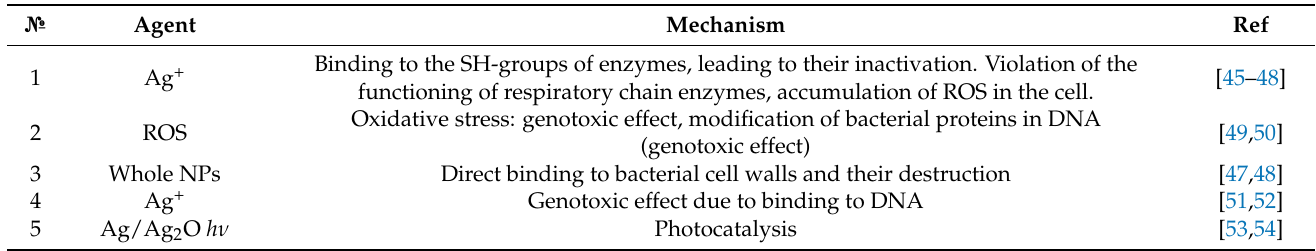
Table 1. Mechanisms of antimicrobial action of Ag 2 O/Ag